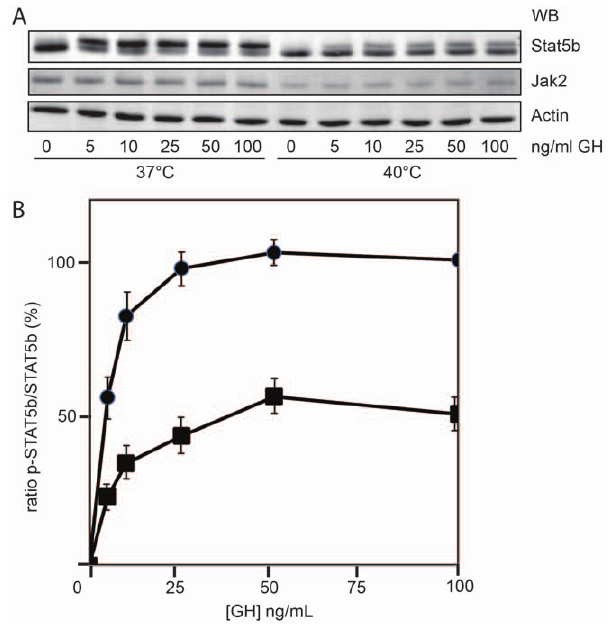
Figure 2. JAK/STAT signaling response is diminished under elevated temperature. ( A ) Mouse 3T3-F442A preadipocytes were incubated at 37 or 40 u C for 4 h and then treated with the indicated concentrations of GH for 10 min. The cells were lysed in 1% SDS and equal amounts of lysate were analyzed by western blotting (WB), using anti-Jak2, anti STAT5b and anti-actin antibodies. ( B ) Quantification of Fig. 2A. At each point the ratio of the lower band to the total STAT5b signal was calculated (100 ng/ml GH at 37 u C was set 100%; 0 ng/ml was set 0%). The data represent the mean of four independent experiments + SEM. ( circles , 37 u C; squares , 40 u C).